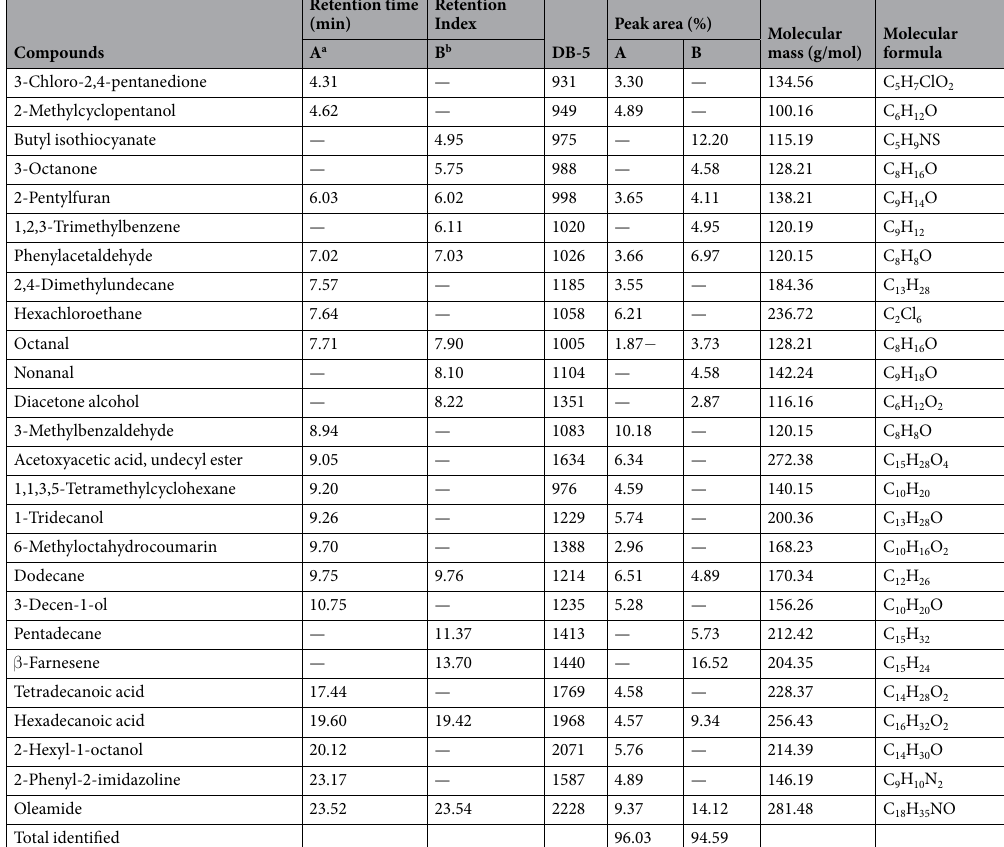
Table 2. Analysis of the components of the essential oils of the Myosotis arvensis aerial parts and seeds ( a M . arvensis aerial parts; b M . arvensis